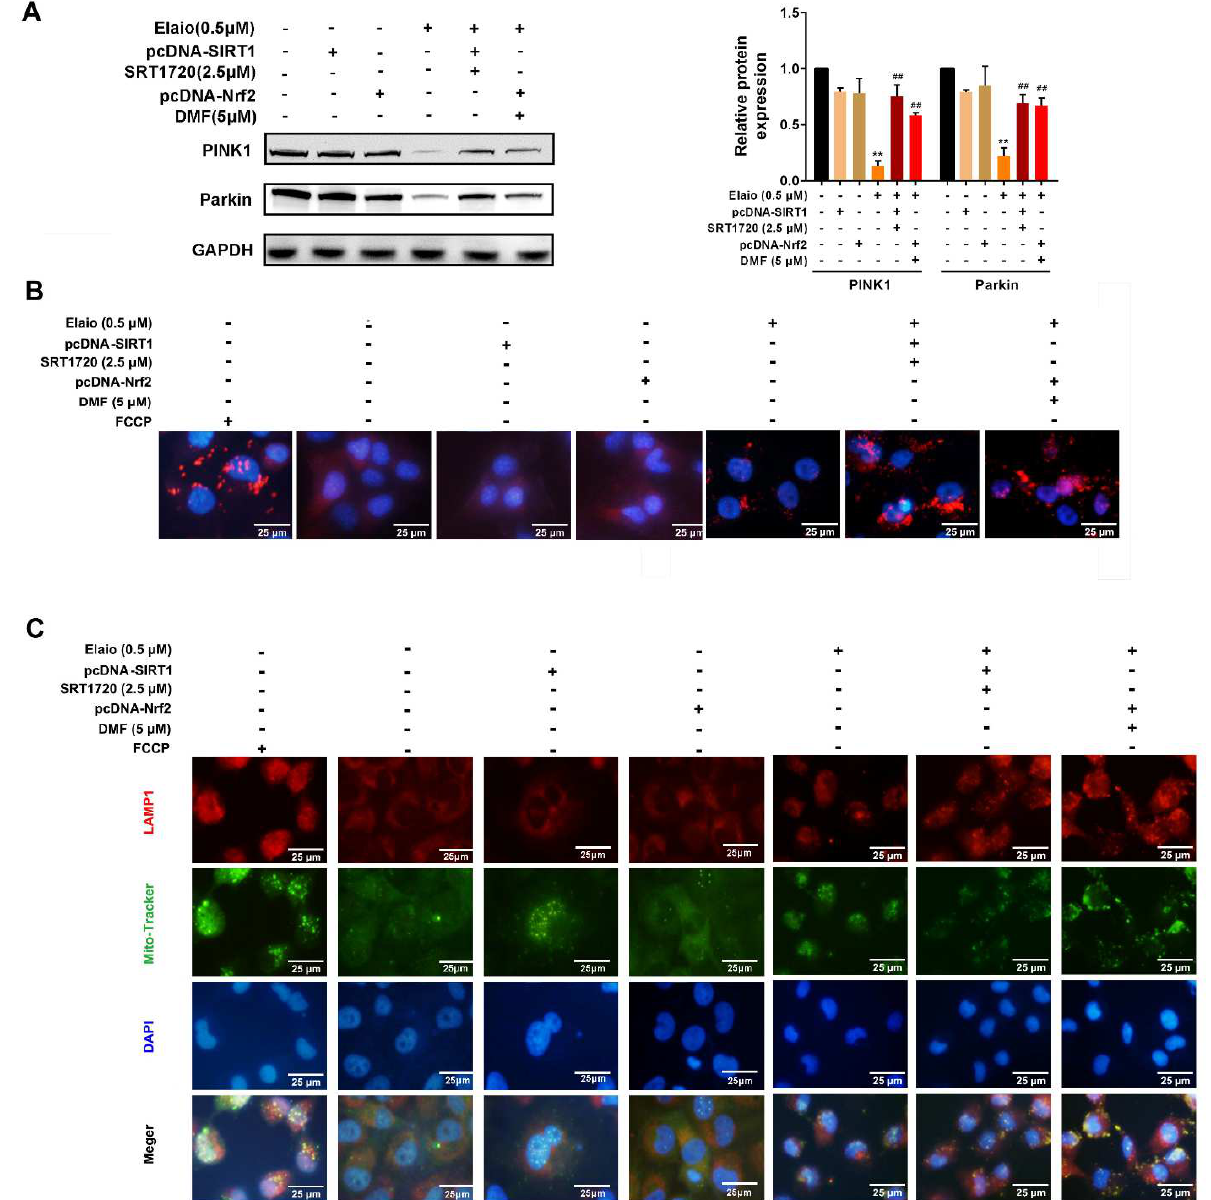
Figure 6. Activation of SIRT1/Nrf2 signaling attenuates the anti-mitophagy effect of elaiophylin in A549 cells. The cells were divided into six groups: control, SIRT1 overexpression only, Nrf2 overexpression only, elaiophylin, elaiophylin+SIRT1 activation (SIRT1 overexpression plus SRT1720), elaiophylin+Nrf2 activation (Nrf2 overexpression plus DMF). ( A ) The expressions of mitophagy- related proteins PINK1 and Parkin were assessed by Western blot analysis. ( B ) Cells overexpressing Mito-Keima were treated with elaiophylin for 24 h. Mito-Keima (red fluorescence) was assessed by a fluorescence microscope. FCCP, a mitophagy stimulant, was used as a positive control. ( C ) Colocal- ization of mitochondria and lysosomes was assessed by MitoTracker (200 nM) and LAMP1 staining. Data were expressed as mean ± SD of three experiments. ** p < 0.01 vs. control, ## p < 0.01 vs. elaiophylin group. Original Western Blots can be found at supplementary materials.